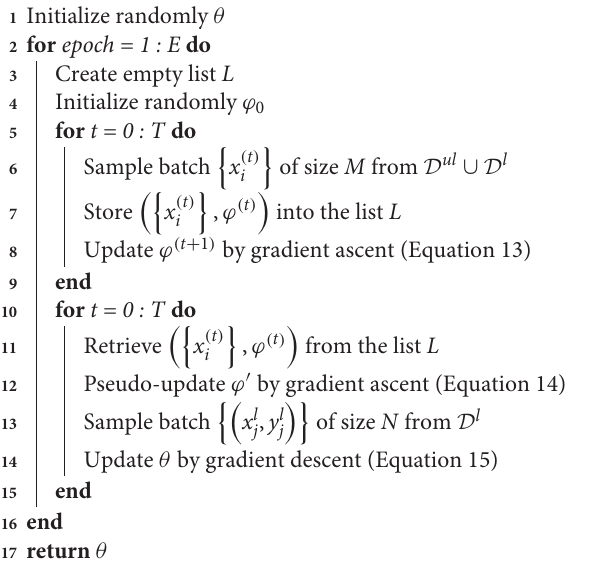
Algorithm 1: Trajectory preserving training